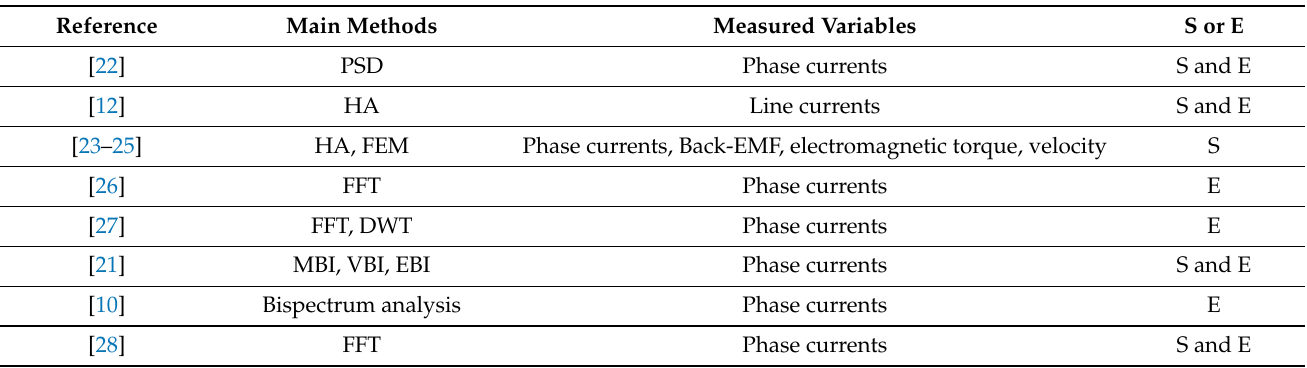
Table 2. Signal based-methods for diagnosing inter-turn faults. E = Experimental environment; S = simulation